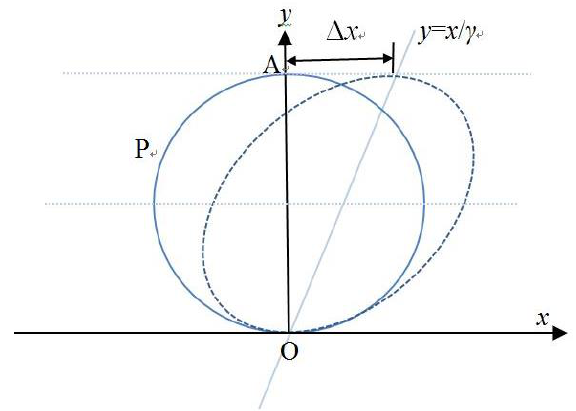
Figure A1. Geometric graph of elongated of